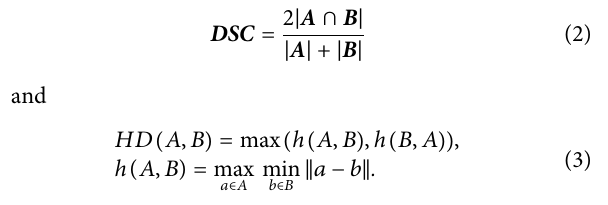
Table 1 provides statistics on the number, categories, and mean organ volumes of the OARs in the dataset. The 24 HaN OARs included the brain, brain stem, spinal cord, spinal cord cavity, eyes (left and right), lens (left and right), optical nerves (left and right), optic chiasma, pituitary, parotid glands, oral cavity, mandible, temporomandibular joint left (TMJ L), temporomandibular joint right (TMJ R), temporal lobes (left and right), larynx, pharynx, trachea, and thyroid.